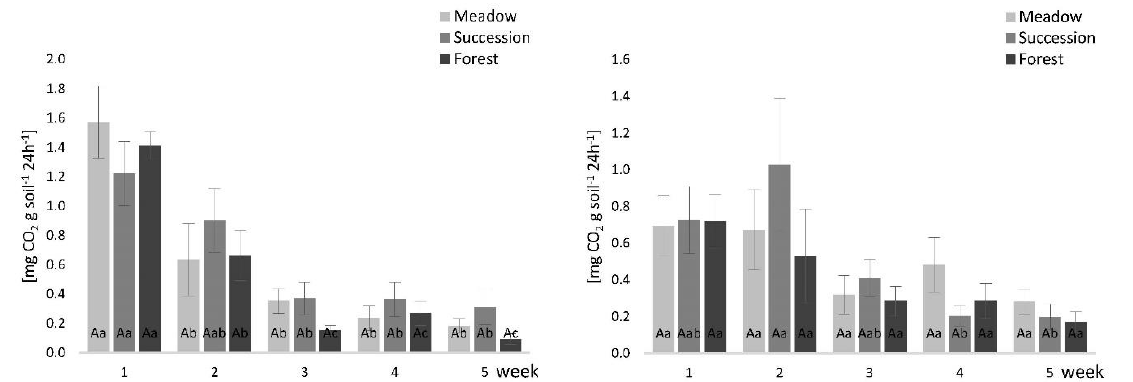
Table 2. Mean and standard error values of cumulative value of mineralized carbon during incubaT- able 35 days (C m ), potentially mineralizable carbon (C 0 ) and rate constant (k) results. The lowercase letters indicate differences between examined soil layers for individual land-use variants, while uppercase letters show differences between land-use variants separately for the 0–10 and 10–20 cm soil layers (Tukey post hoc test, p < 0.05). Standard error is reported behind “ ±